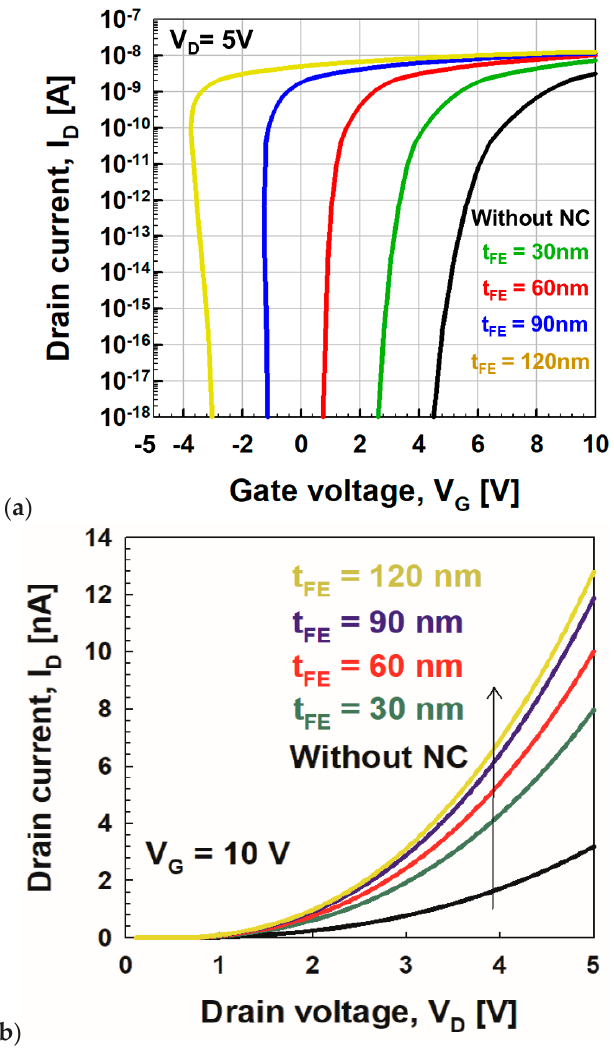
Figure 5. Simulated ( a ) I D vs. V G and ( b ) I D vs. V D curves of negative capacitance vacuum channel transistors for various ferroelectric thicknesses ( t FE = 30 nm, 60 nm, 90 nm, and 120 nm). The S-shape of thicker than 60-nm-thick ferroelectric-HfSiO indicates the hysteresis behavior.